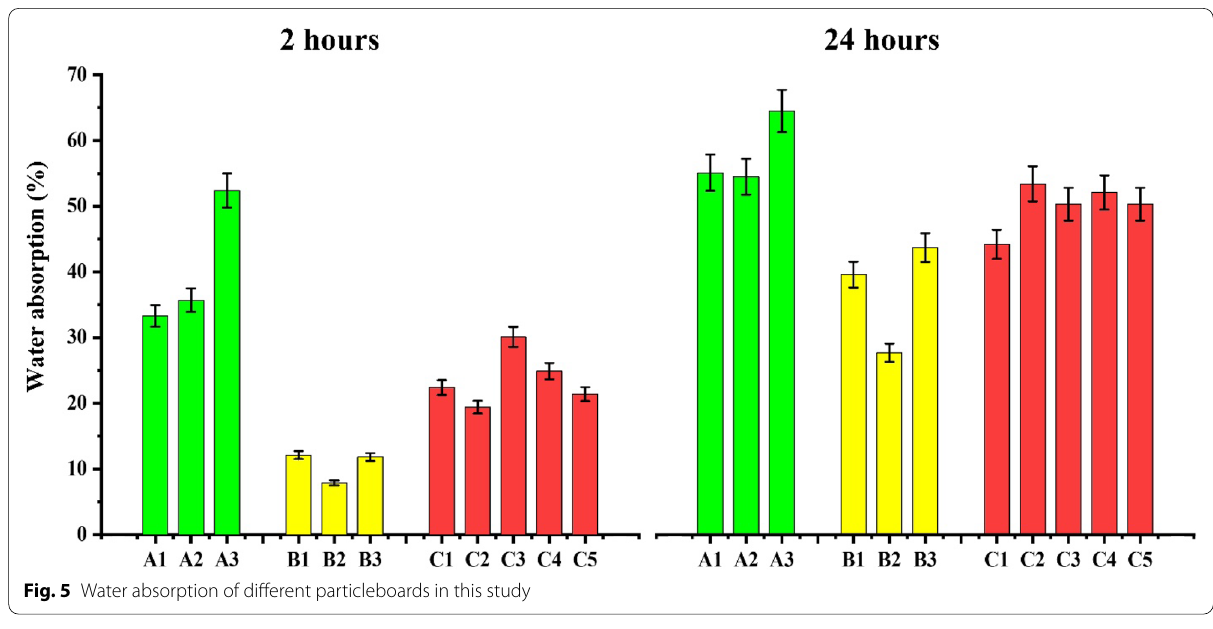
Fig. 5 Water absorption of different particleboards in this study